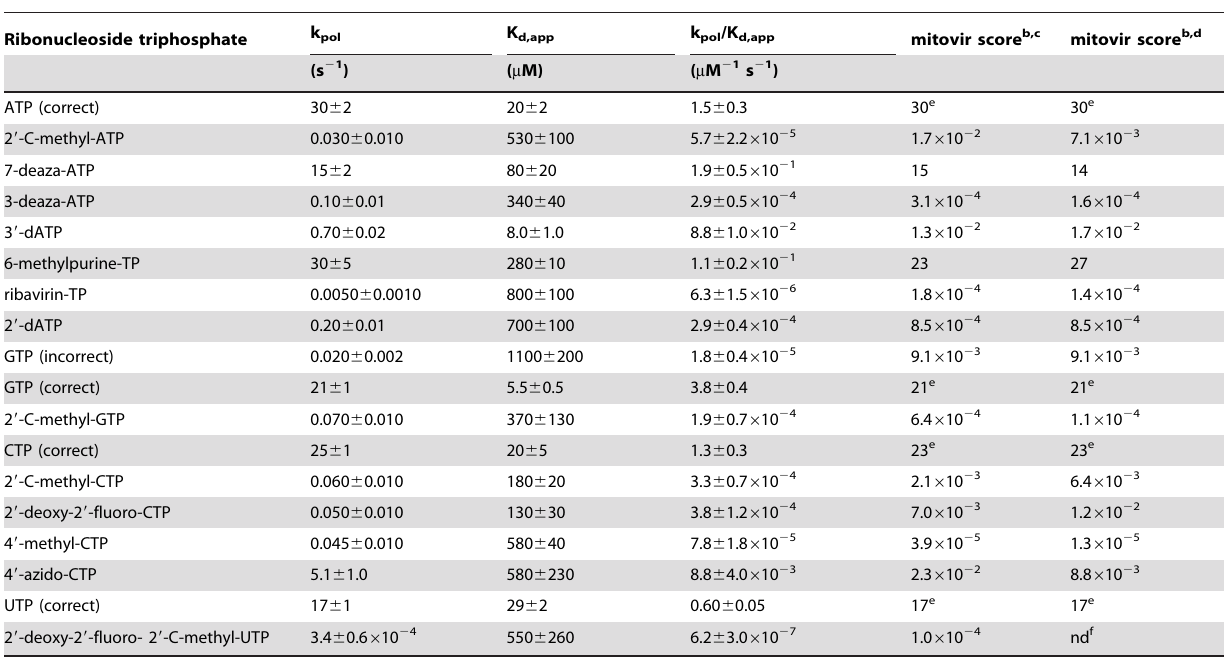
Table 2. Kinetic parameters for POLRMT-catalyzed nucleotide incorporation a .